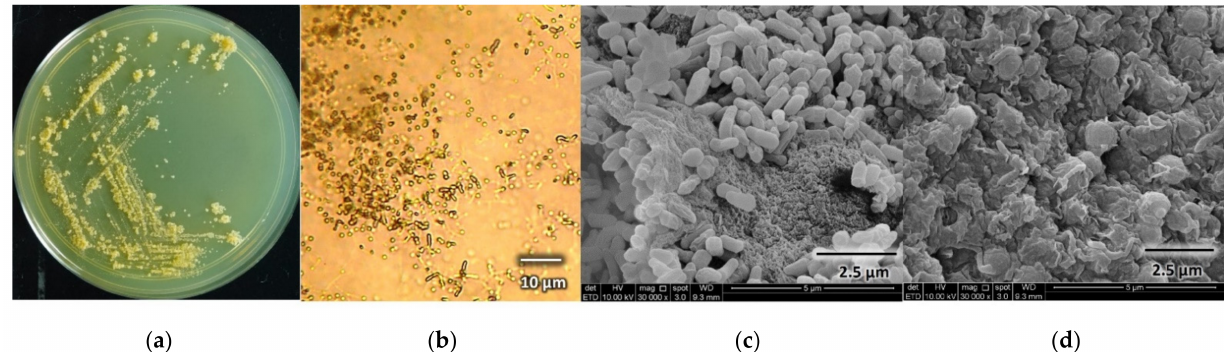
Figure 4. Dactylosporangium sp. AC04546 morphology: ( a ) surface morphology on Yeast Malt Extract (ISP2) agar; ( b ) spore- forming structures viewed using light microscope at 750 × magnification on Soil Extract agar (SEA); ( c ) oblong-shaped sporangia viewed using scanning electron microscope (SEM Quanta FEG 650); ( d ) globose bodies viewed using scanning electron microscope (SEM Quanta FEG